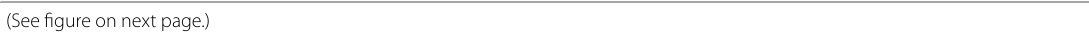
axis(See figure on next Fig. 6 Results of h w = 8 cm (run 14, H = 20 cm, h w / H = 0.40 ) case in which 2 slides are triggered, followed by a spread (Additional file 2: Movie S2). a Images, and b time-series data of the sensor measurements (5-point running averaged). A blue (cid:31) is the seepage time T seep . A green (cid:31) indicates the (cid:31) z (from which v z is obtained) that defines the slide time T slide . See Fig. 4 legend for explanations of the red bar and blue × on the left